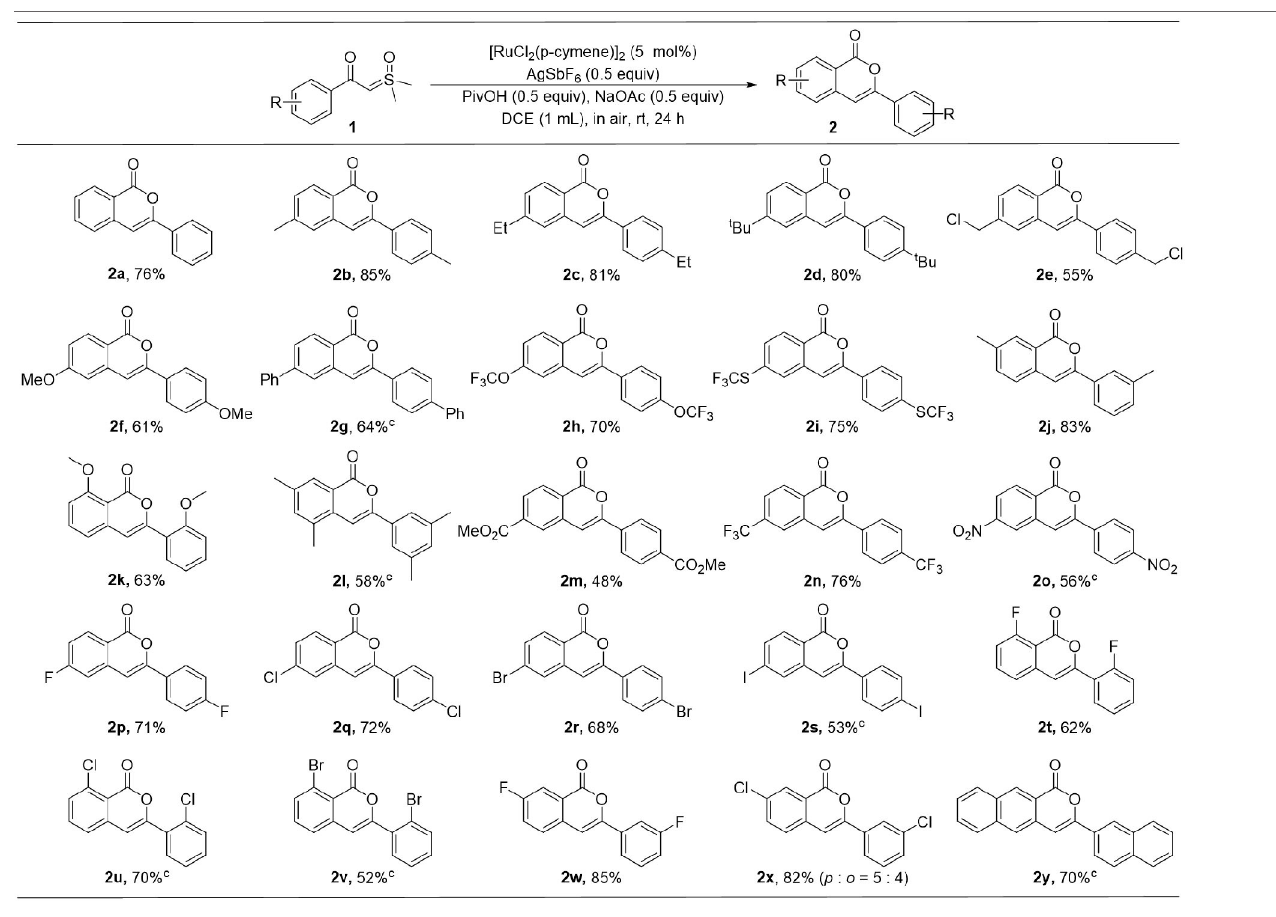
TABLE 2 | Variation of α -carbonyl sulfoxonium ylides a,b